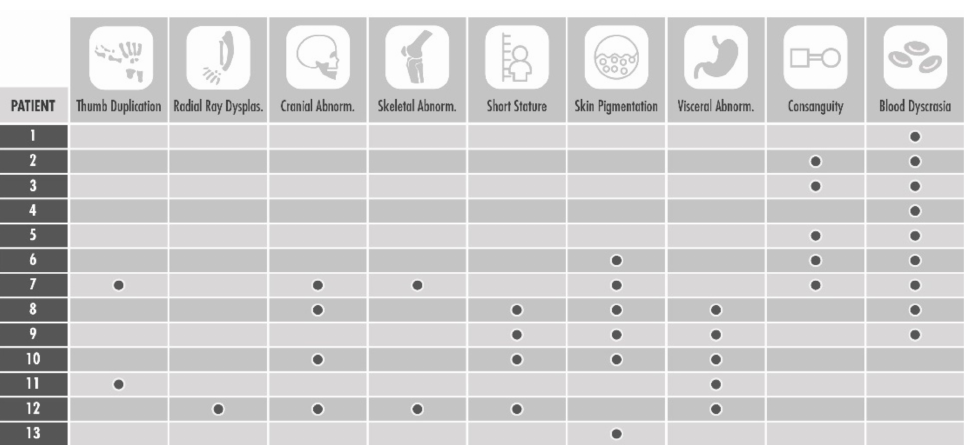
Figure 1. Features of the 13 patients tested positive for Fanconi